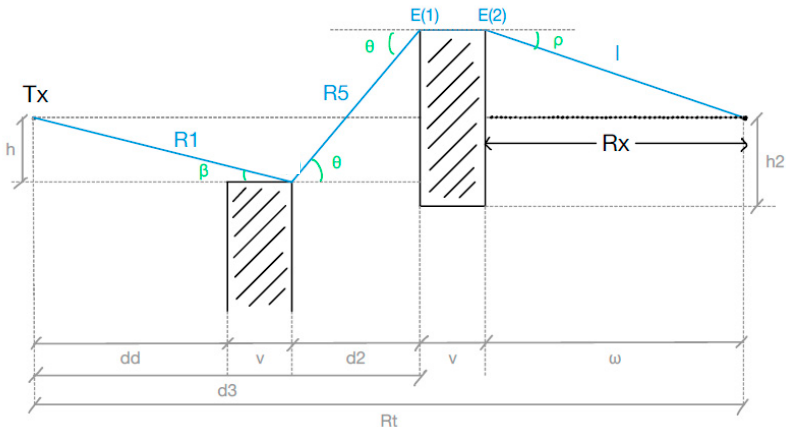
Figure 20. Second triple diffraction (Edif_t2) of the second considered NLOS scenario.